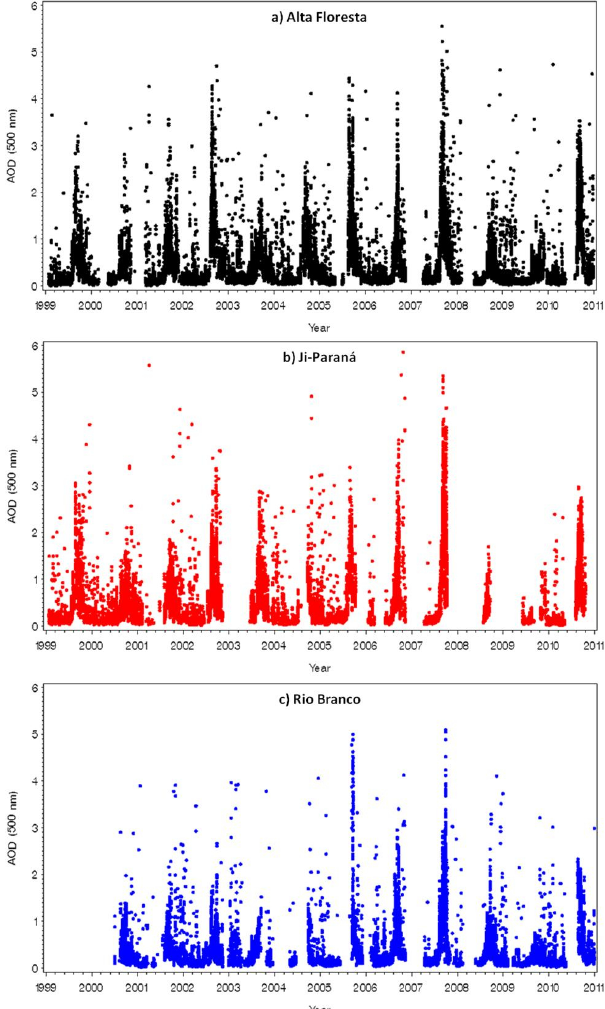
Fig. 2. Time series of aerosol optical depth (AOD) at 500nm re- trieved by AERONET sun-photometer for 3 places in Amazonia: (a) Alta Floresta, (b) Ji-Paran´a and (c) Rio Branco. This graph il- lustrates the high seasonality in the aerosol